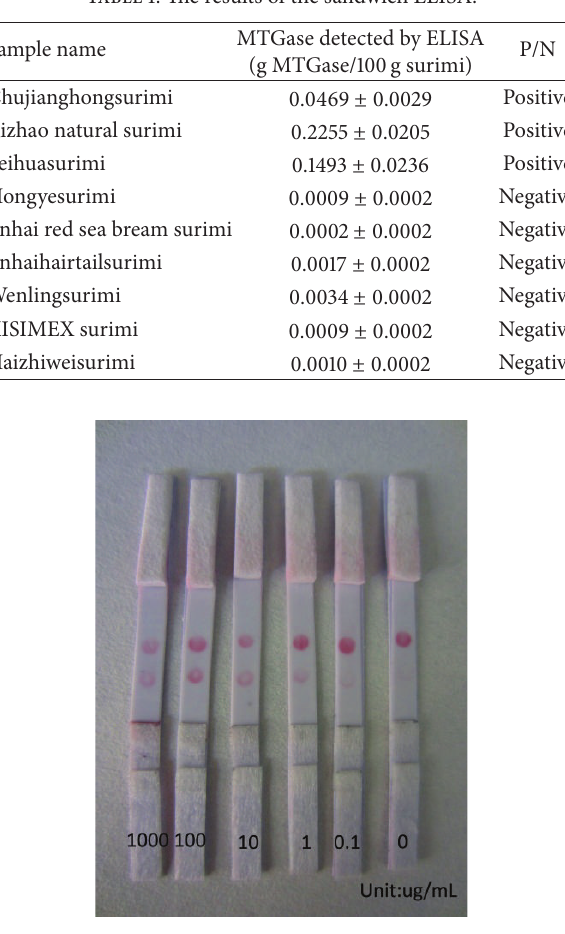
Figure 7: Detection of the sensitivity of the immunochromato- graphic strip.